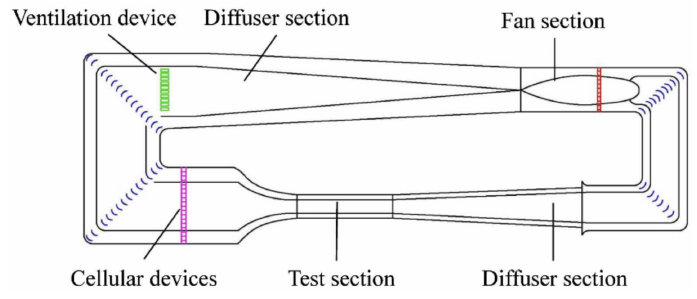
Figure 23. Wind tunnel.